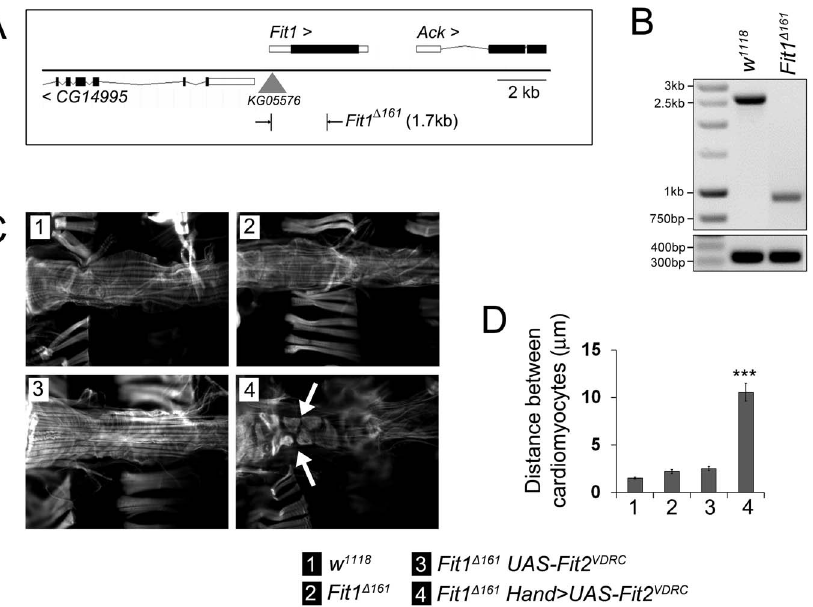
Figure 5. Cardiomyocyte Fit2 compensates for the loss of Fit1 to establish the cardiac syncytium. ( A ) Schematic showing the Fit1 locus with the adjacent genes ( CG14995 and Ack ) and the site of the P-element insertion used to create the 1.7 kb deletion mutant ( Fit1 D 161 ). ( B ) PCR of genomic DNA from wild-type ( w 1118 ) and Fit1 D 161 mutant flies. ( C ) Micrographs of adult hearts stained with phalloidin. The arrow highlights an abnormal cardiomyocyte phenotype. ( D ) Mean ( 6 SEM) distance between neighbouring cardiomyocytes. n =12–16 measurements from four to seven independent flies for each genotype. ***P , 0.001 from all other genotypes. Legend applies to C & D. doi:10.1371/journal.pone.0062958.g005 PLOS ONE |